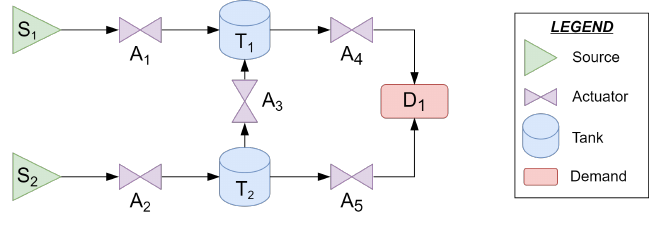
Figure 2. Simple network